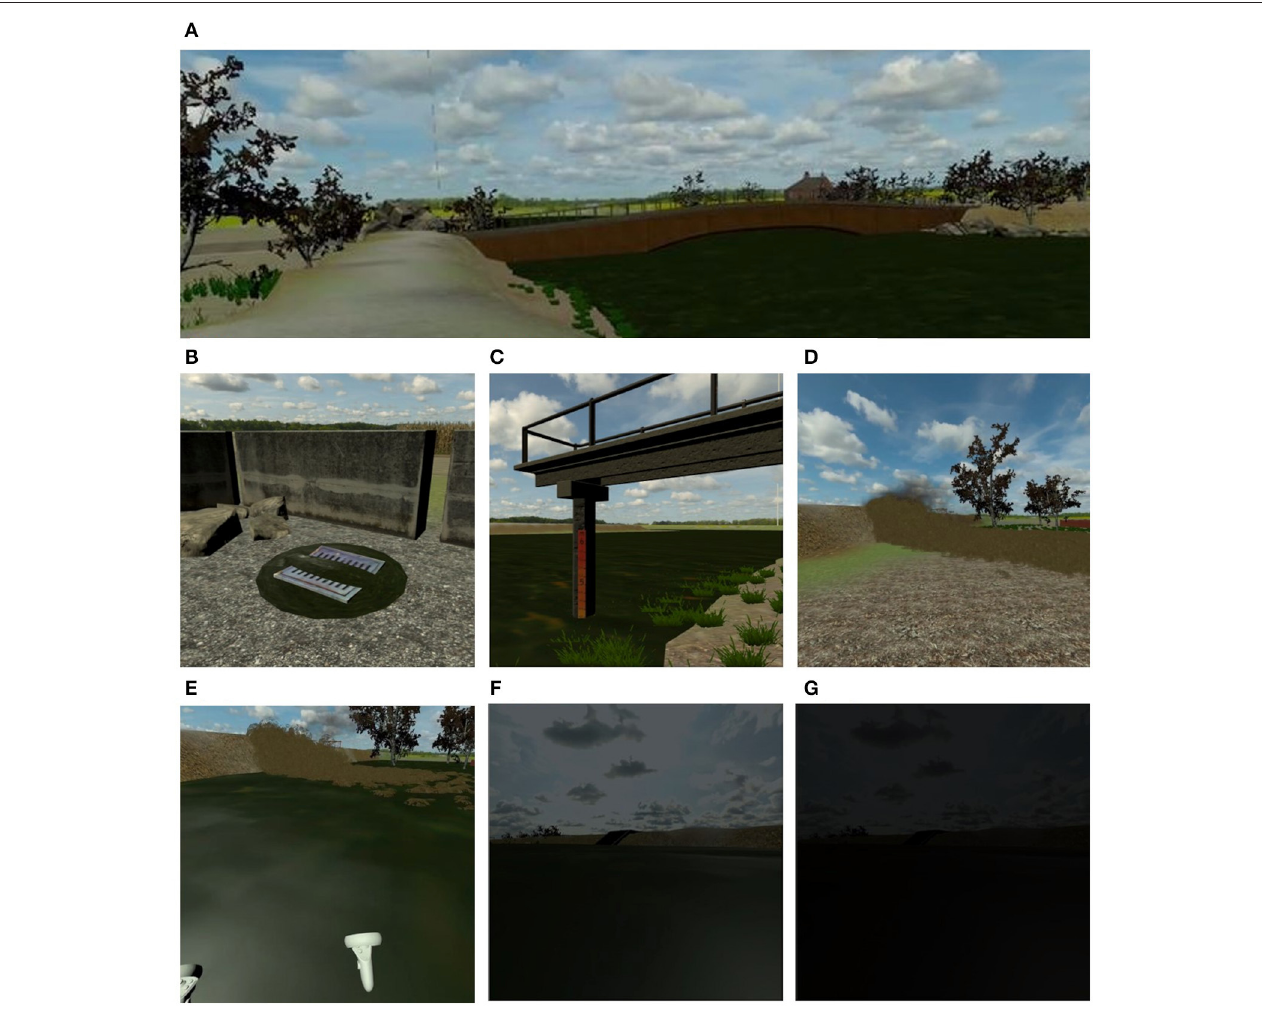
FIGURE 4 | (A) A frame of the VE representing the initial part of the path along the river area. (B) A flooded manhole, one of the physical indicators of danger. (C) A hydrometer, an example of artificial indicator that facilitates the recognition of the high water level. ( D ) The breakdown of the river embankment. (E) While the water level rises, (F) the user fails to reach a high point, and (G) the screen slowly fades to